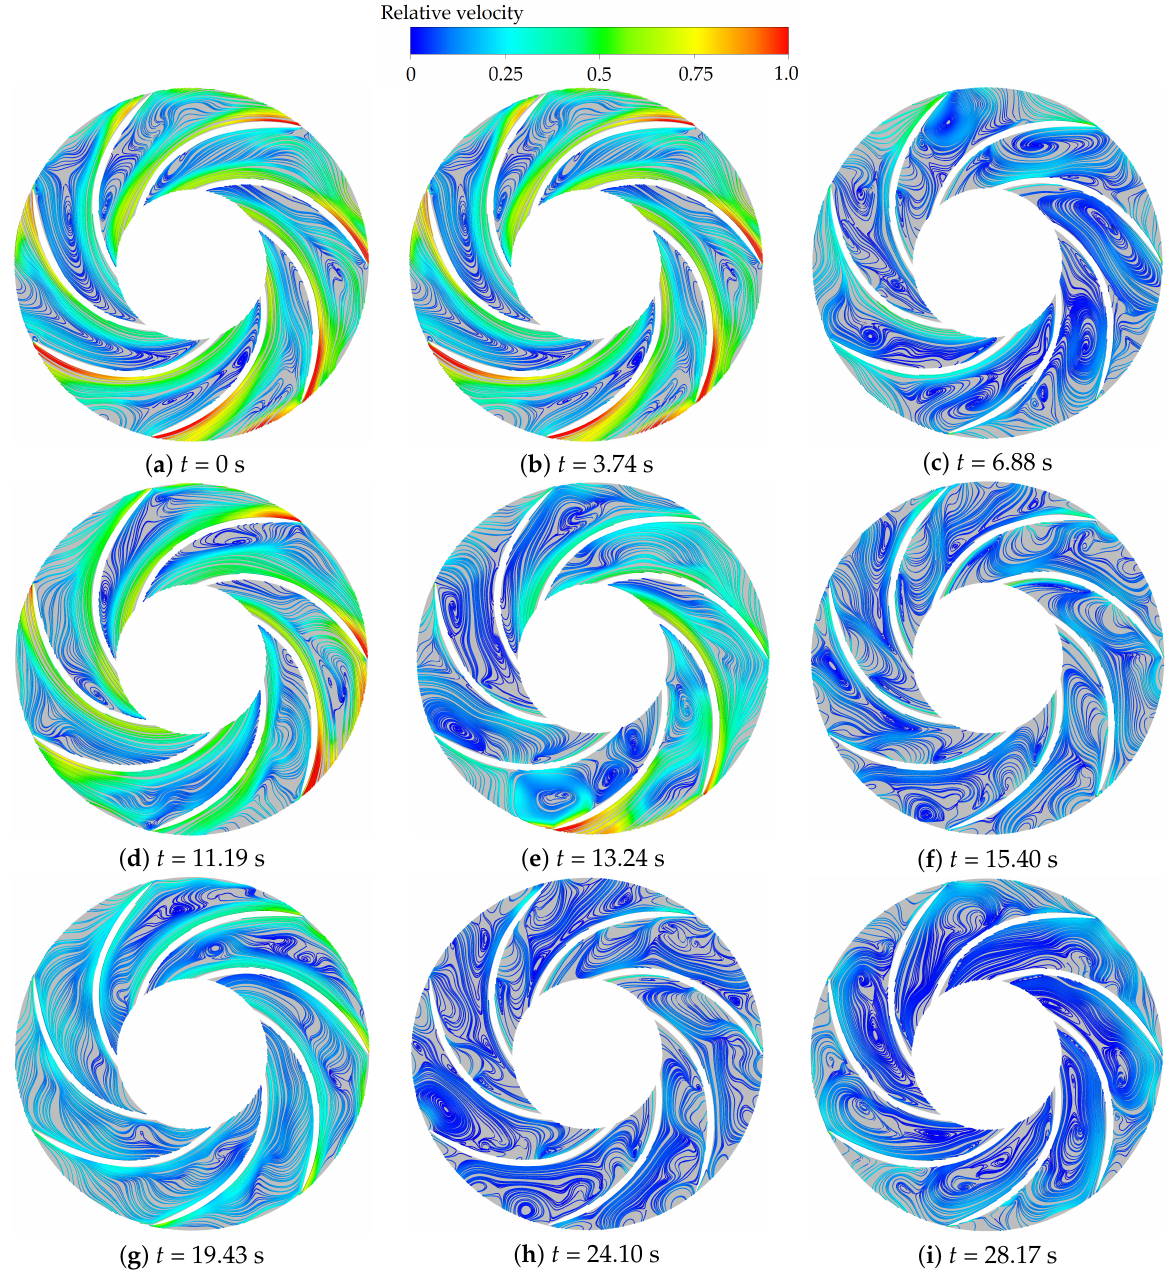
Figure 8. Flow pattern in the runner